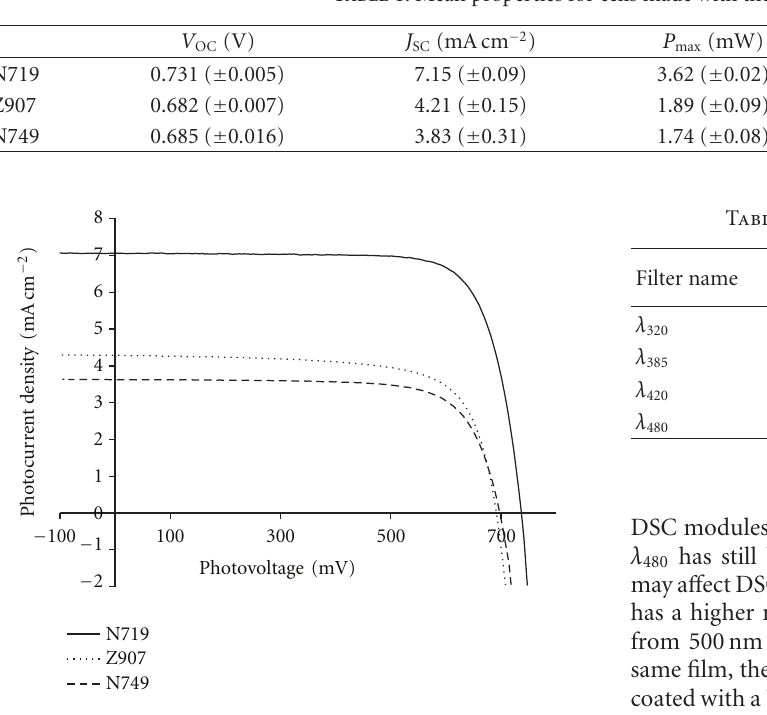
Figure 2: Comparison of typical I - V curves for the three di ff erent dyes.